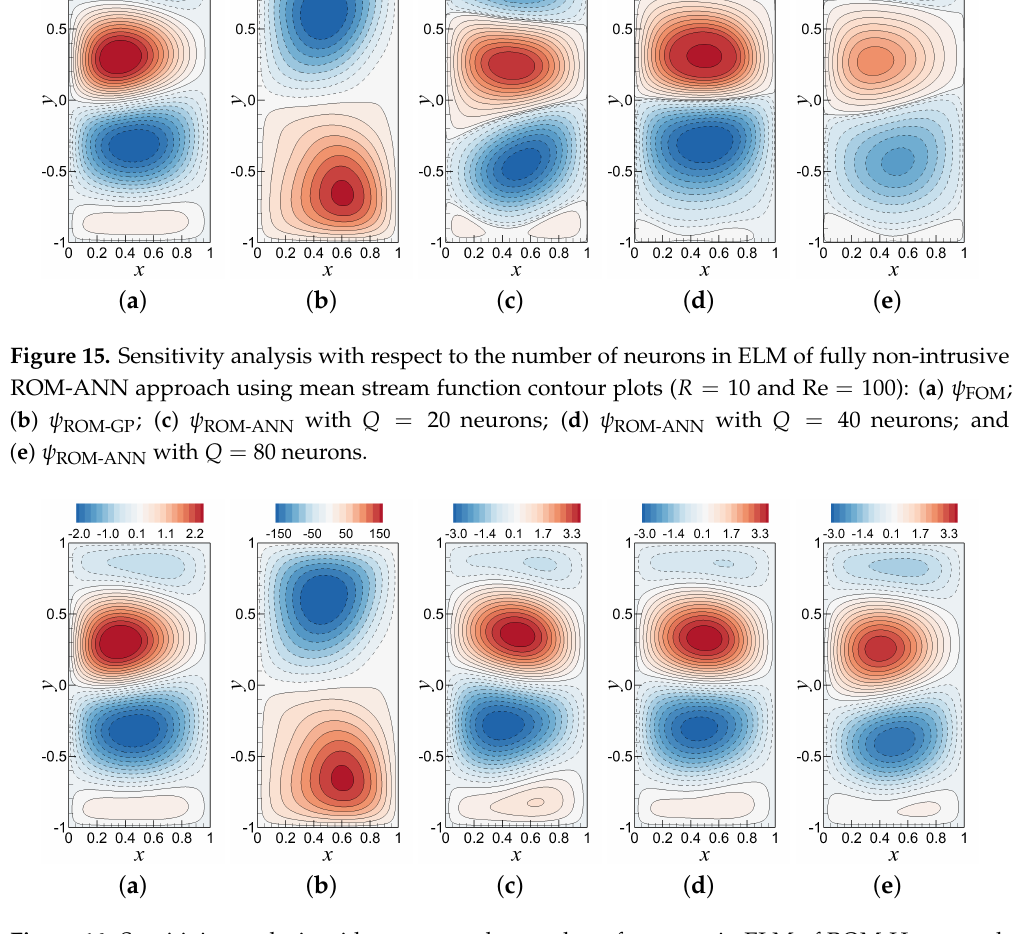
Figure 16. Sensitivity analysis with respect to the number of neurons in ELM of ROM-H approach using mean stream function contour plots ( R = 10 and Re = 100): ( a ) ψ FOM ; ( b ) ψ ROM-GP ; ( c ) ψ ROM-H with Q = 20 neurons; ( d ) ψ ROM-H with Q = 40 neurons; and ( e ) ψ ROM-H with Q = 80